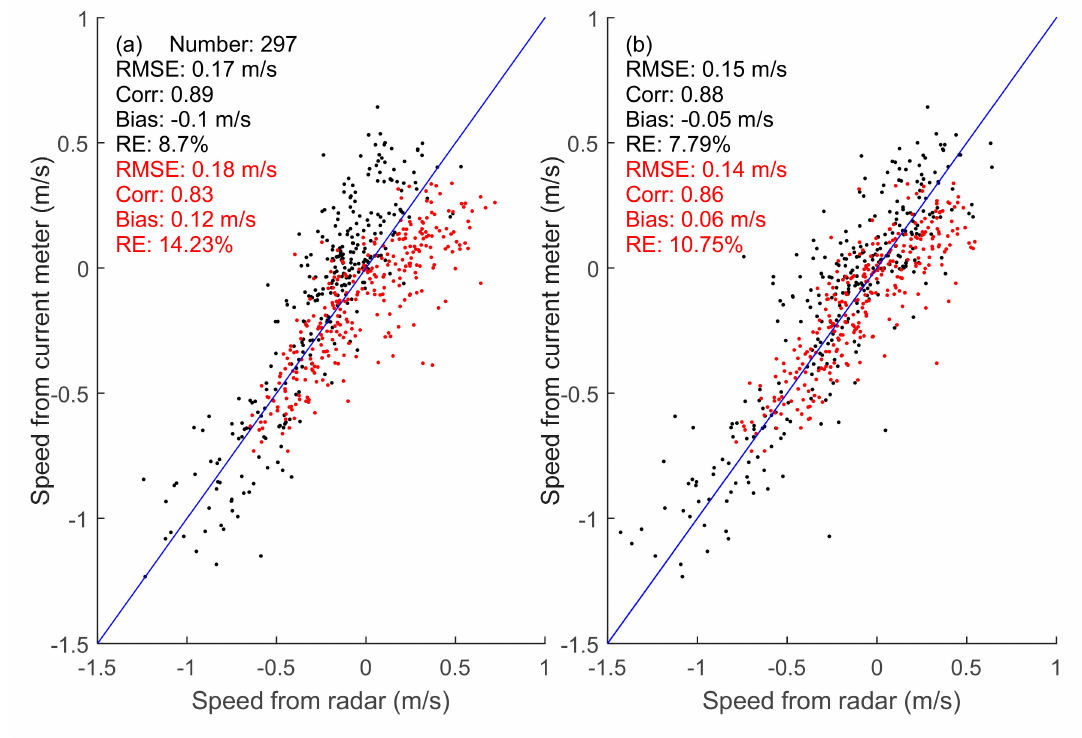
Figure 4. Comparisons of the current velocities measured by current meter with those retrieved from X-band marine radar image sequences using di ff erent methods: ( a ) CSP1 and ( b ) CSP2. The black dots and digits are NS current velocities, and the red dots and digits are EW current velocities.